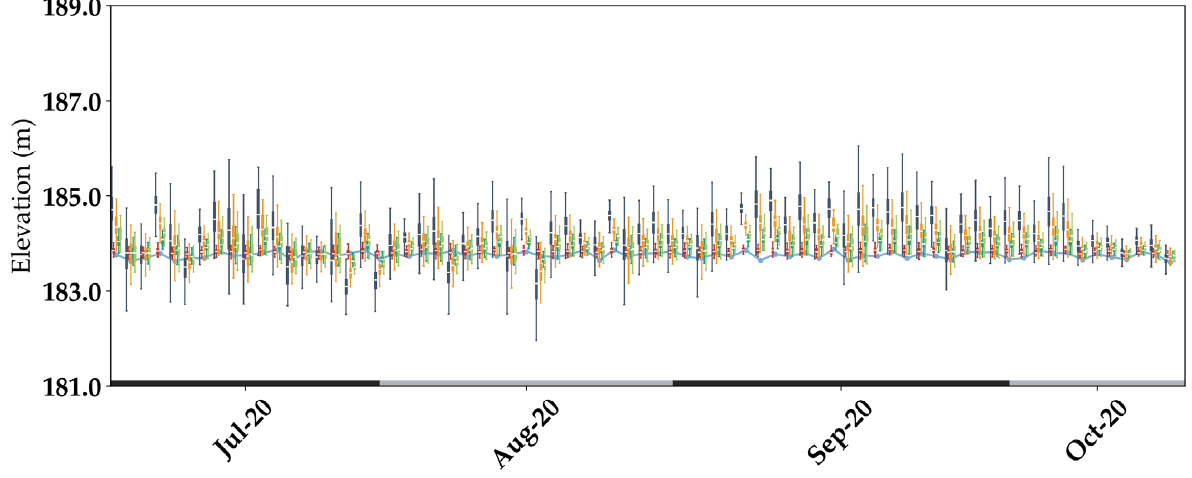
Figure A5. Boxplot by track of the original estimated elevations by GEDI over Lake Superior and the four tested models presented in Sections 3.1.1 and 3.1.2. The blue line represents in situ elevations.